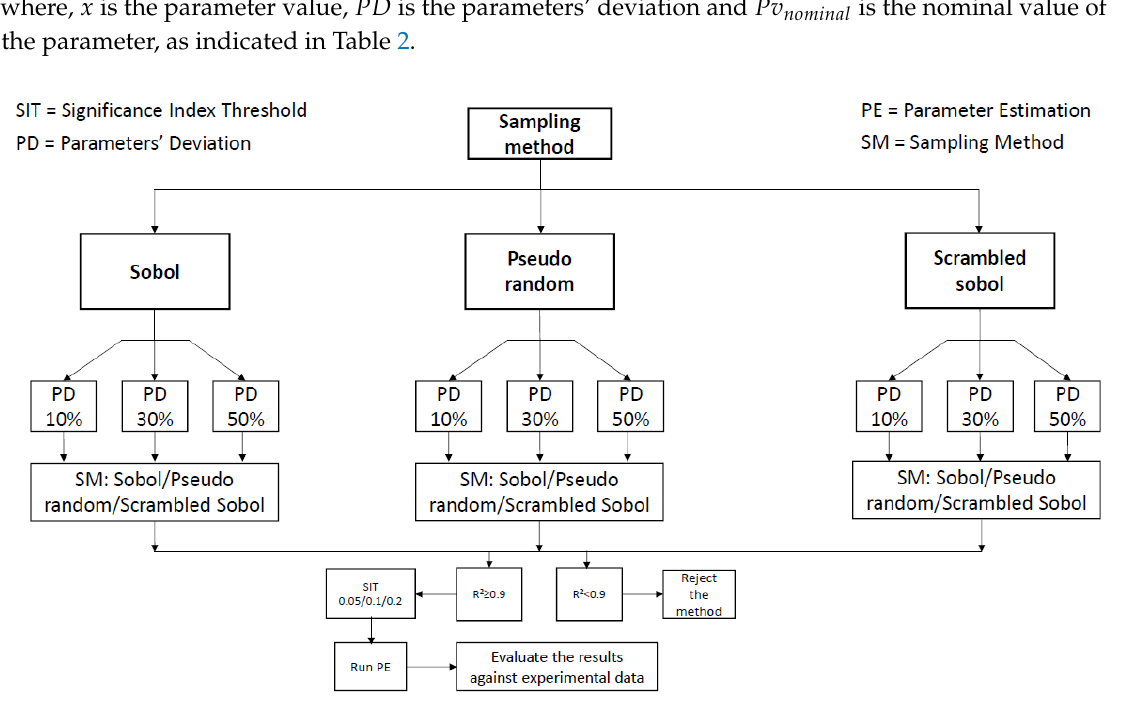
Figure 2. Workflow graph for the methods used to evaluate the significant parameters.